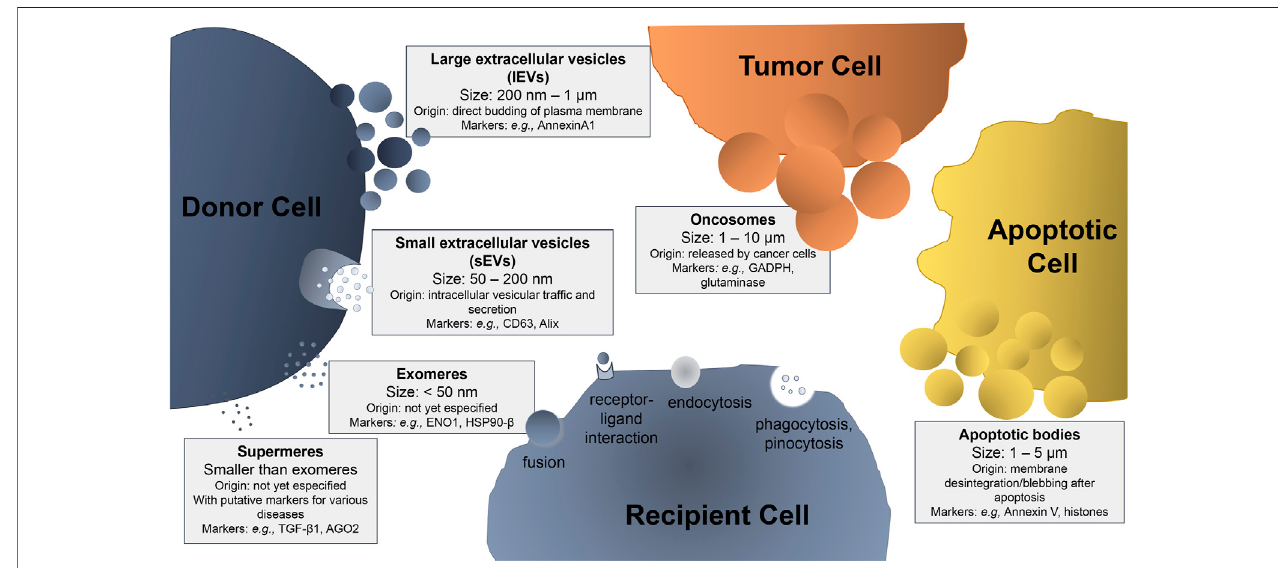
FIGURE1 | Schematic representation ofthe extracellular vesicles (EVs) subtypes, sizes, and characteristic markers. Depending on their sizeand site of origin, EVs canbeclassi fi edas:i)largeextracellularvesicles(lEVs),alsomentionedasectosomesormicrovesicles,whentheirsizerangesfrom200 nmto1 μ m,generatedfromthe budding of the plasma membrane; ii) small extracellular vesicles (sEVs), also referred as exosomes, with a diameter from 50 to 200 nm, which are formed after inward budding of endosomal vesicle membrane and maturation in multivesicular bodies that later fuse with the plasma membrane to be secreted into the extracellular space; iii) oncosomes, which are EVs secreted by tumor cells, with a size ranging from 1 to 10 μ m (relatively larger than lEVs) and responsible for the spreading of the tumor; iv) apoptotic bodies that are EVs secreted by apoptotic cells upon their membrane disintegration after apoptosis, with a size ranging from 1 to 5 μ m; (v) amembraneous exomeres that present a size smaller than 50 nm, whose origin is not fully understood yet; and (vi) amembraneous supermeres that are smaller and morphologically distinct from exomeres. The cell that releases EVs into the medium is called the donor cell and the one that internalizes EVs is the recipient cell. EV internalization in the recipient cell can occur by dissecting mechanisms, such as: a) fusion, when the membrane of the vesicle becomes contiguous with the cell membrane,releasingitscontentsintothecell;b)receptor-ligandinteraction, whenthevesiclehasaspeci fi cligandinitsmembrane thatwillbindtoaspeci fi creceptoron the cell membrane allowing its internalization; c) endocytosis, when the vesicle is internalized by the plasma membrane; d) phagocytosis, when the vesicle is larger than 0.5 μ m, being engulfed by the target cell; and e) pinocytosis in the case of fl uid absorption (macropinocytosis of solute molecules larger than 200 nm and micropinocytosis of smaller particles). Some examples of characteristic markers used in EV identi fi cation are included.